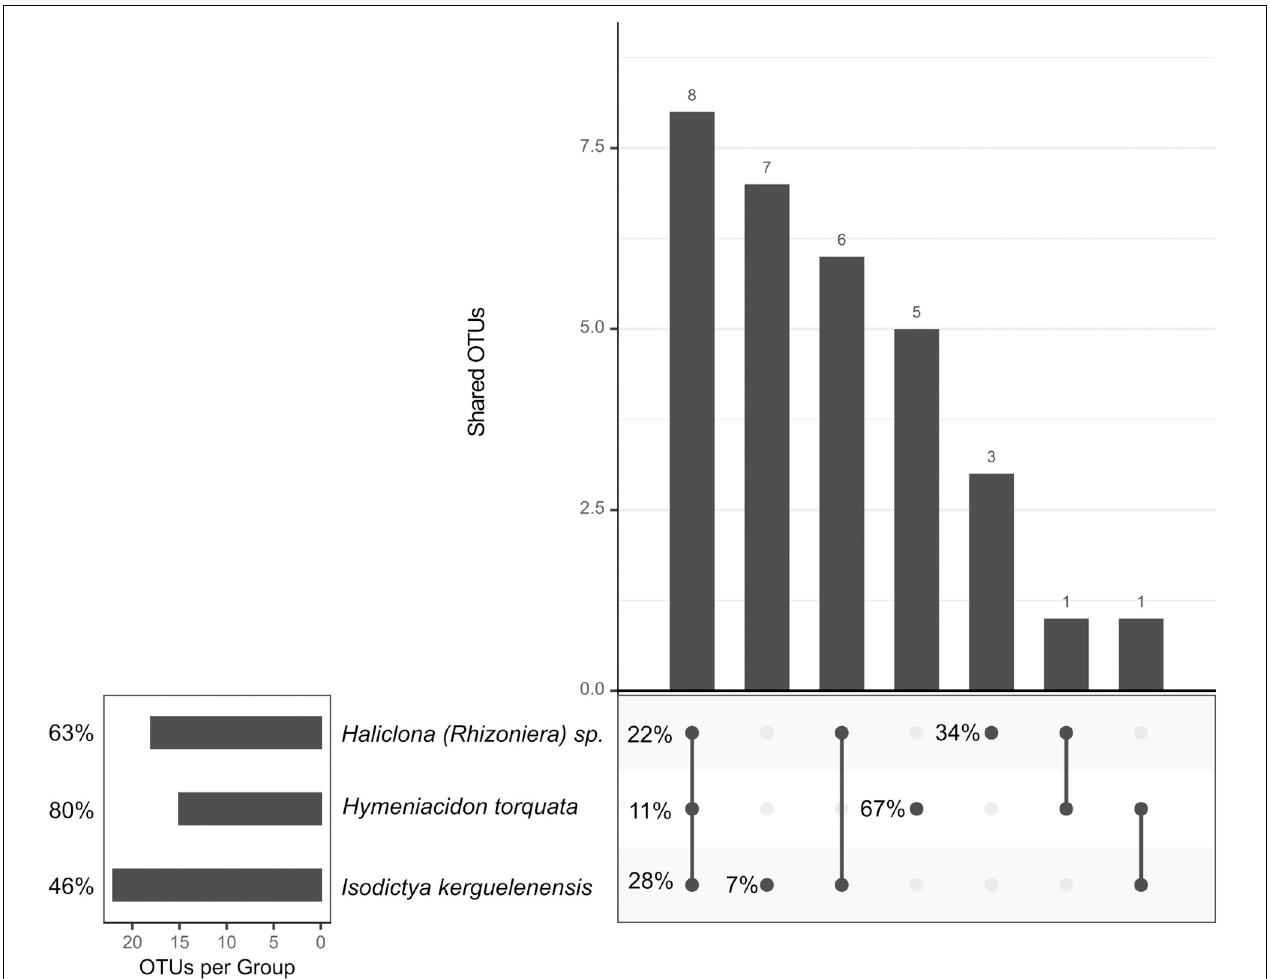
FIGURE 4 | Upset plot showing the number of shared OTUs and representing the sponge core community. Percentages indicate the average contribution of those core OTUs to the microbial community relative